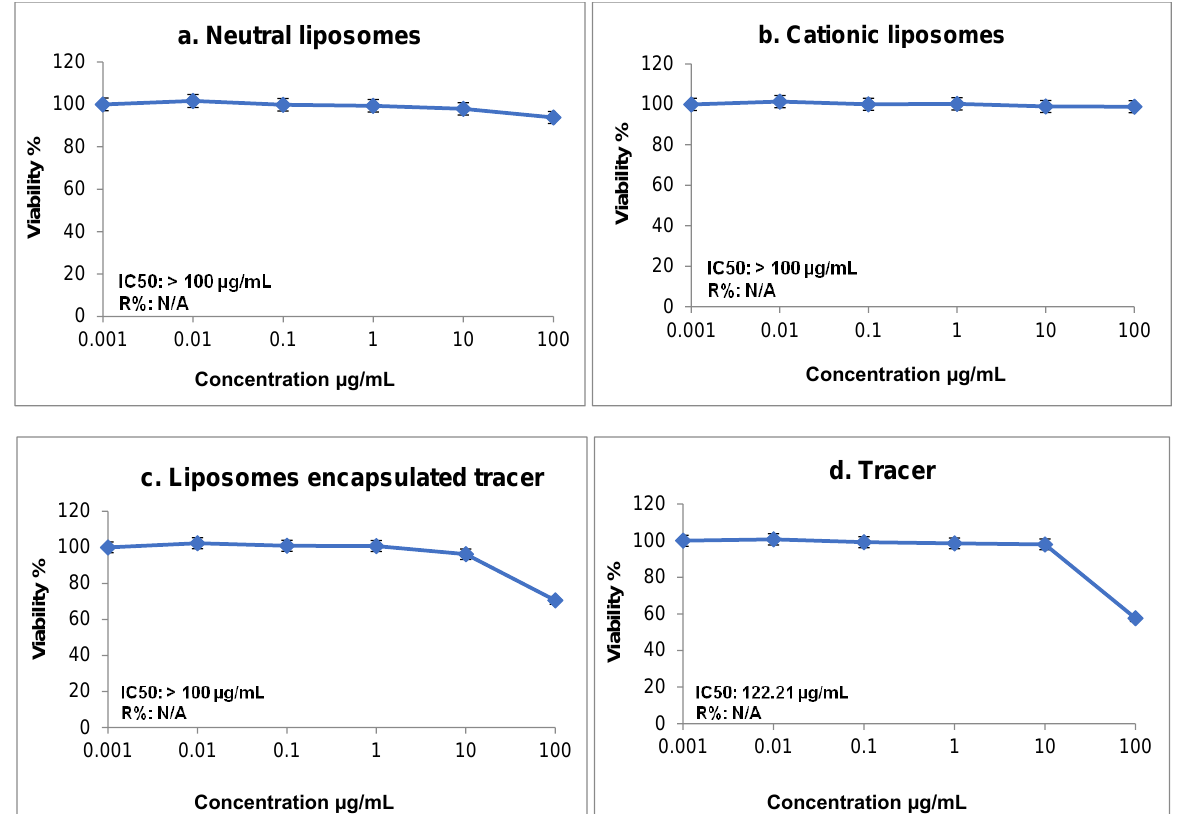
Figure 2. Dose-response curves assessed by SRB showing the cytotoxic activities of ( a ) neutral empty liposomes ( b ) cationic empty liposomes, and ( c ) liposomes encapsulated with tracer MIBI, as well as the effect of ( d ) control, tracer MIBI, on the cell viability of an (H9C2) rat heart/myocardium. Cells were maintained in DMEM supplemented with 100 mg/mL of streptomycin, 100 units/mL of penicillin, and 10% heat-inactivated fetal bovine serum in a humidified 5% ( v/v ) CO 2 atmosphere at 37 °C. Aliquots of 100 µL cell suspen sion ( 5 × 1 0 3 cells) were seeded in 96-well plates and incubated in complete media for 72 h.